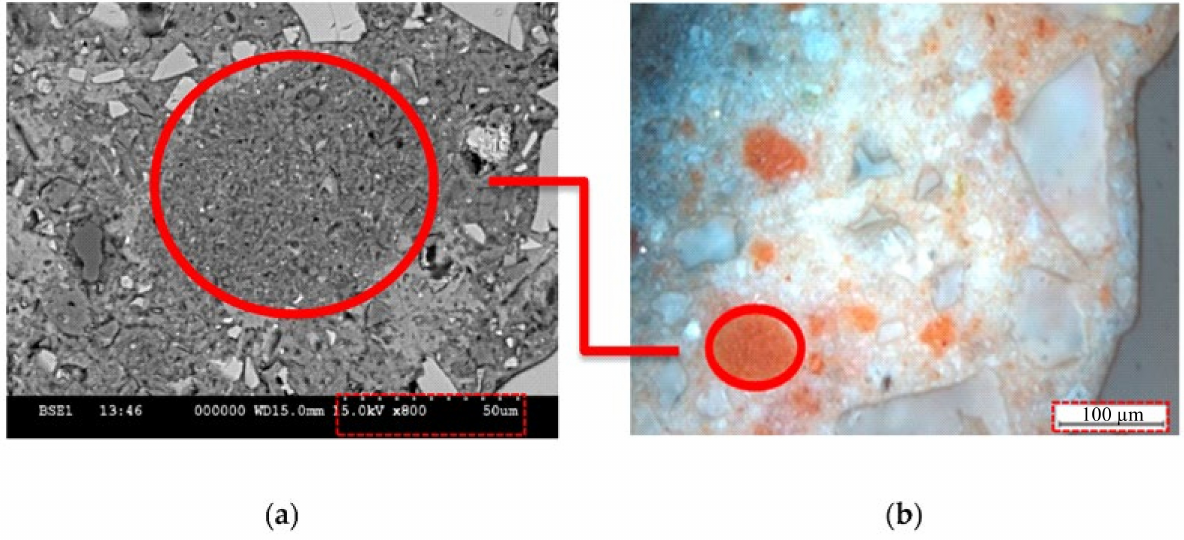
Figure 18. SEM ( a ) and optical ( b ) microscopy on 80C10GGBS10CS after 56 days of